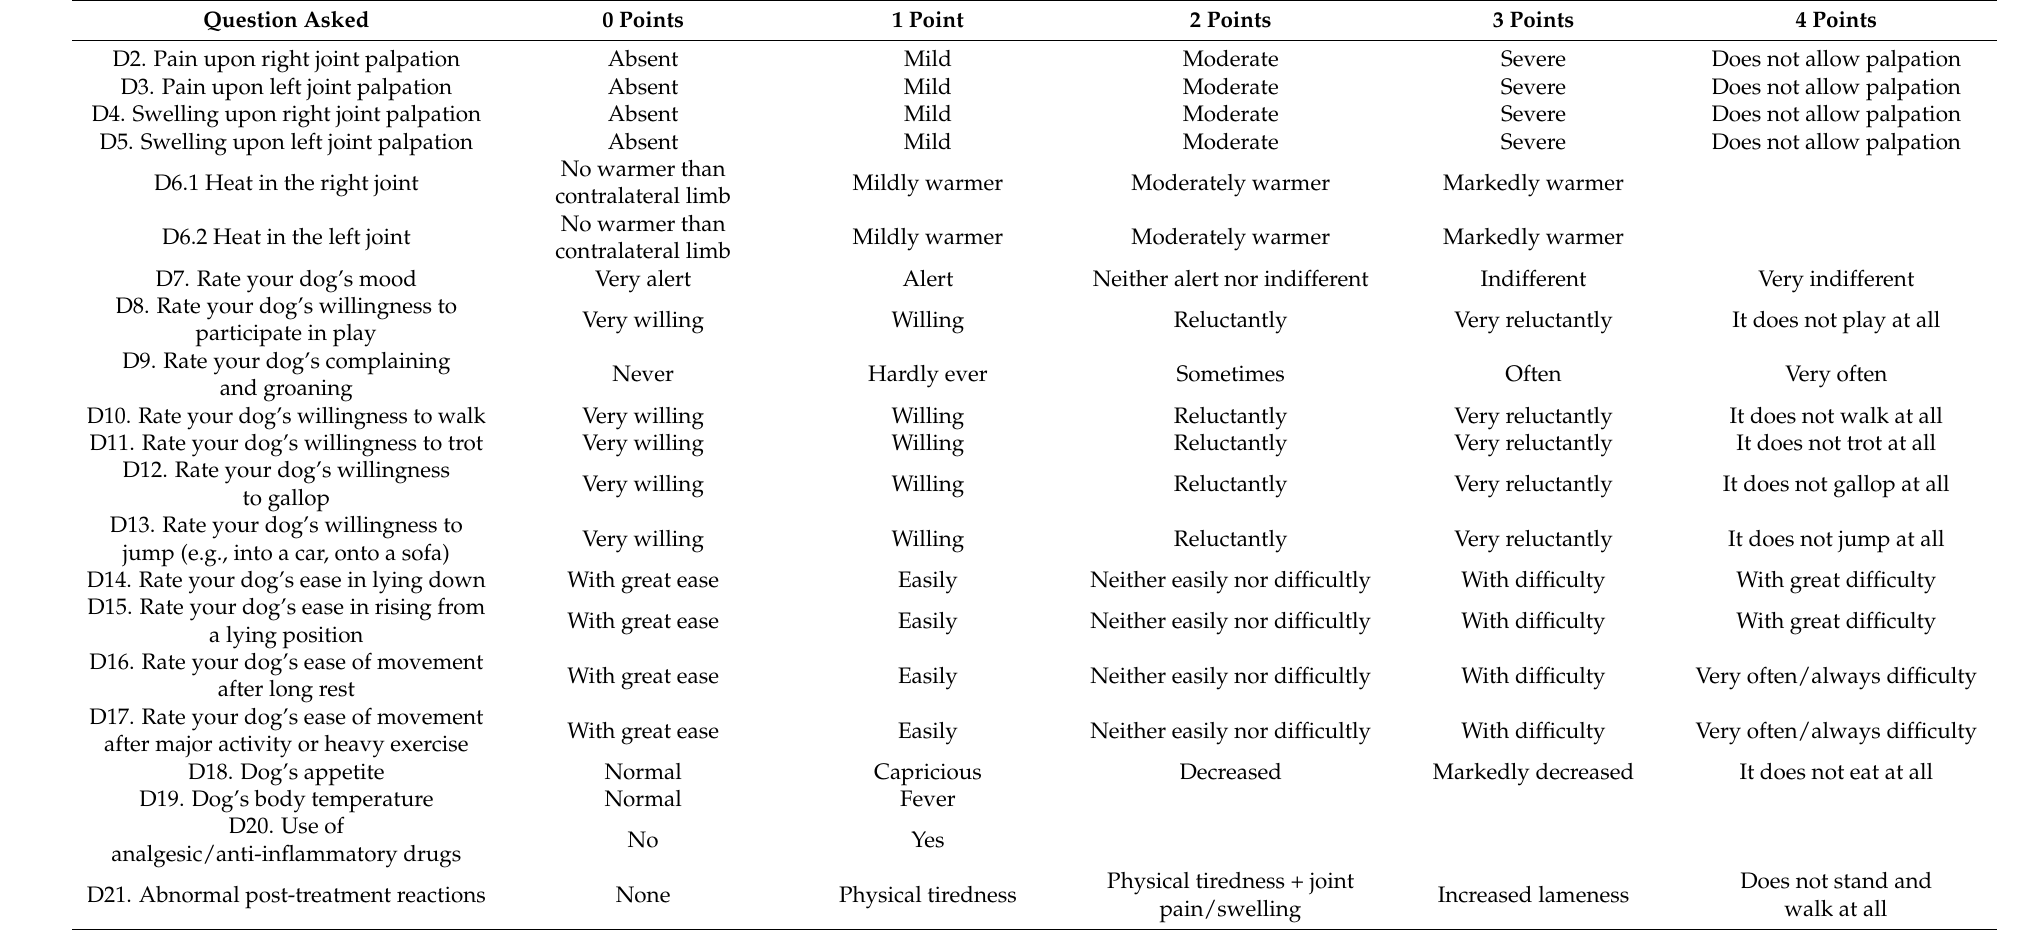
Table 6. Questionnaire submitted to the owners. The questionnaire is based on Helsinki chronic pain index (HCPI), with additional information collected to evaluate local and systemic adverse reactions reported by the animal